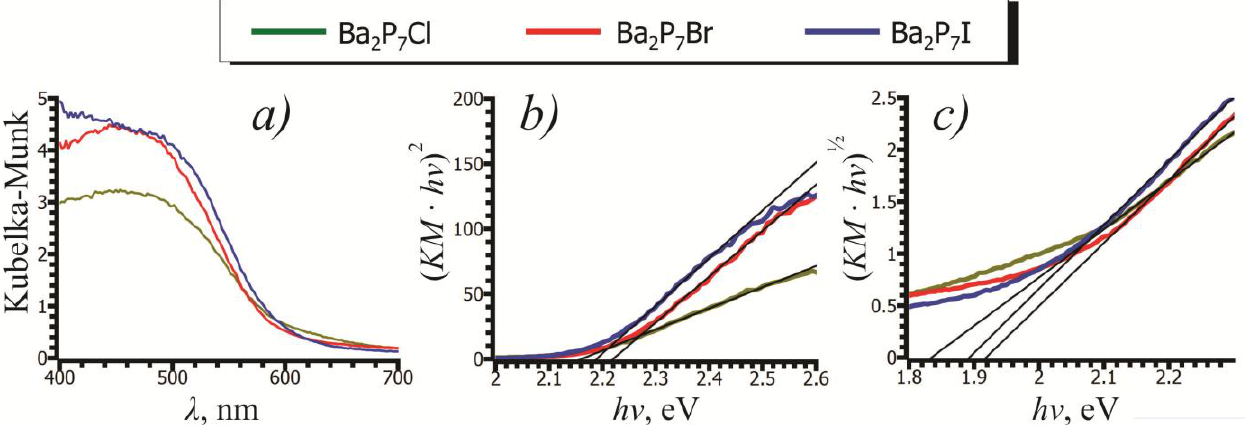
Figure 7. Solid-state UV-Visible spectra of Ba ( a ) Kubelka-Munk diffuse reflectance; ( b ) and ( c ) Tauc plots for allowed direct and indirect transitions,